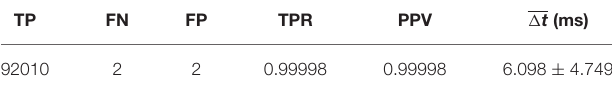
TABLE 1 | Shown are the relevant performance metrics of the algorithm on the entire data